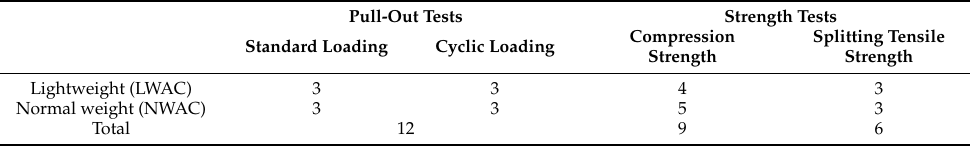
Table 1. Number of test